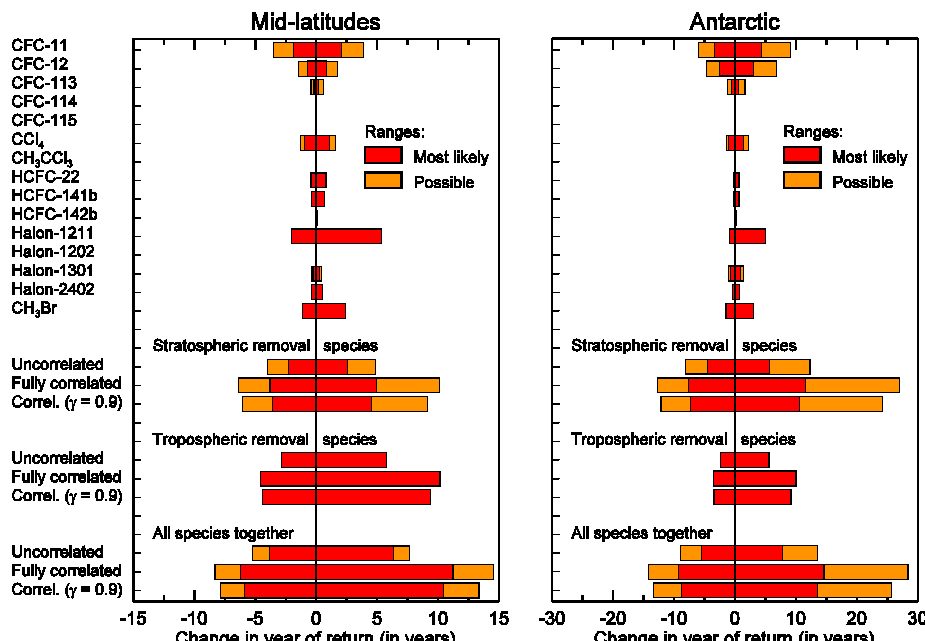
Figure 5 Fig. 5. Uncertainties (difference from the median, 95% confidence interval) in the years of return to pre-1980 levels for midlatitude and Antarctic springtime conditions resulting from uncertainties in the ODS lifetimes from SPARC (2013). The contributions from the individual ODSs are shown as well as the combined contributions from all species removed primarily in the stratosphere, all removed in the tropo- sphere, and all species together. The combined contributions are shown with uncorrelated uncertainties in lifetimes ( γ = 0), fully correlated uncertainties ( γ = 1), and with a correlation coefficient γ of 0.9. The year of return in the base run is 2048 for midlatitudes and 2075 for Antarctic spring conditions. The data of this table is also presented in Table S1 in the Supplement).